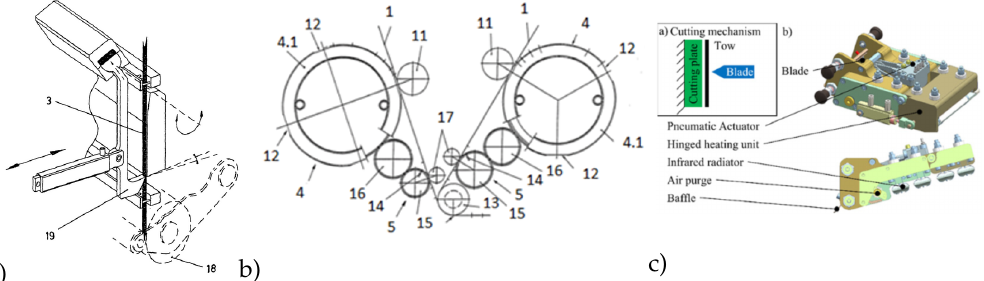
Figure 3. Schematics of the different cutting systems